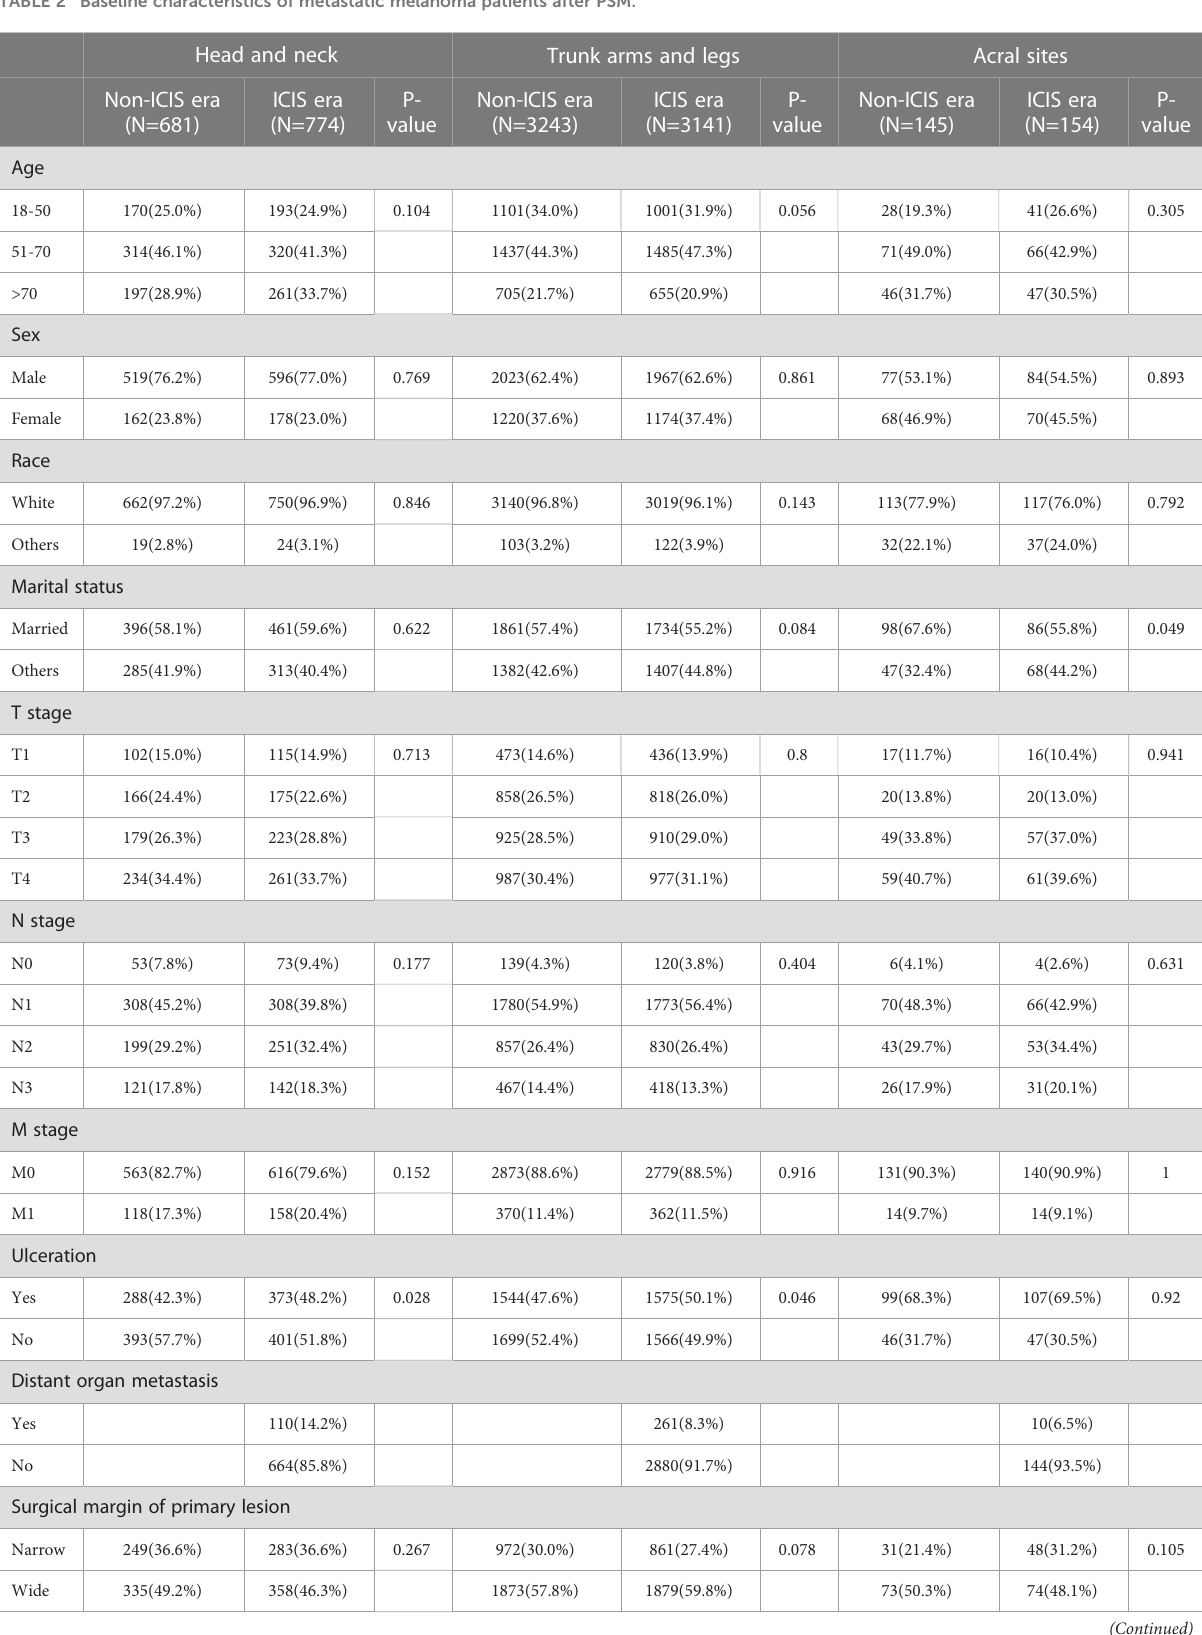
TABLE 2 Baseline characteristics of metastatic melanoma patients after